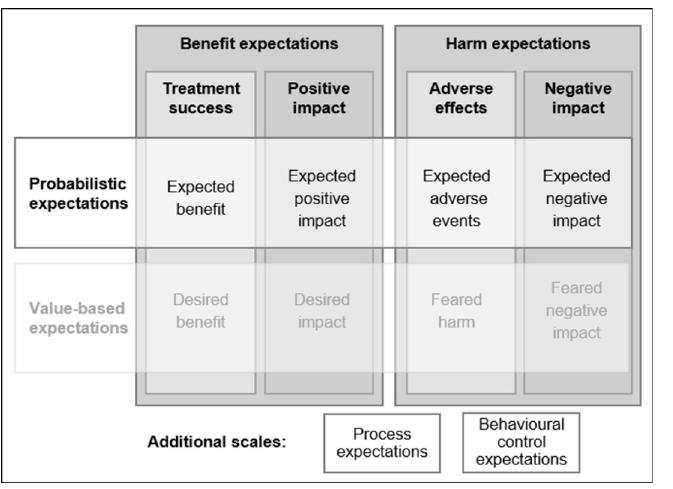
Fig 1. Conceptual structure of the Treatment Expectation Questionnaire